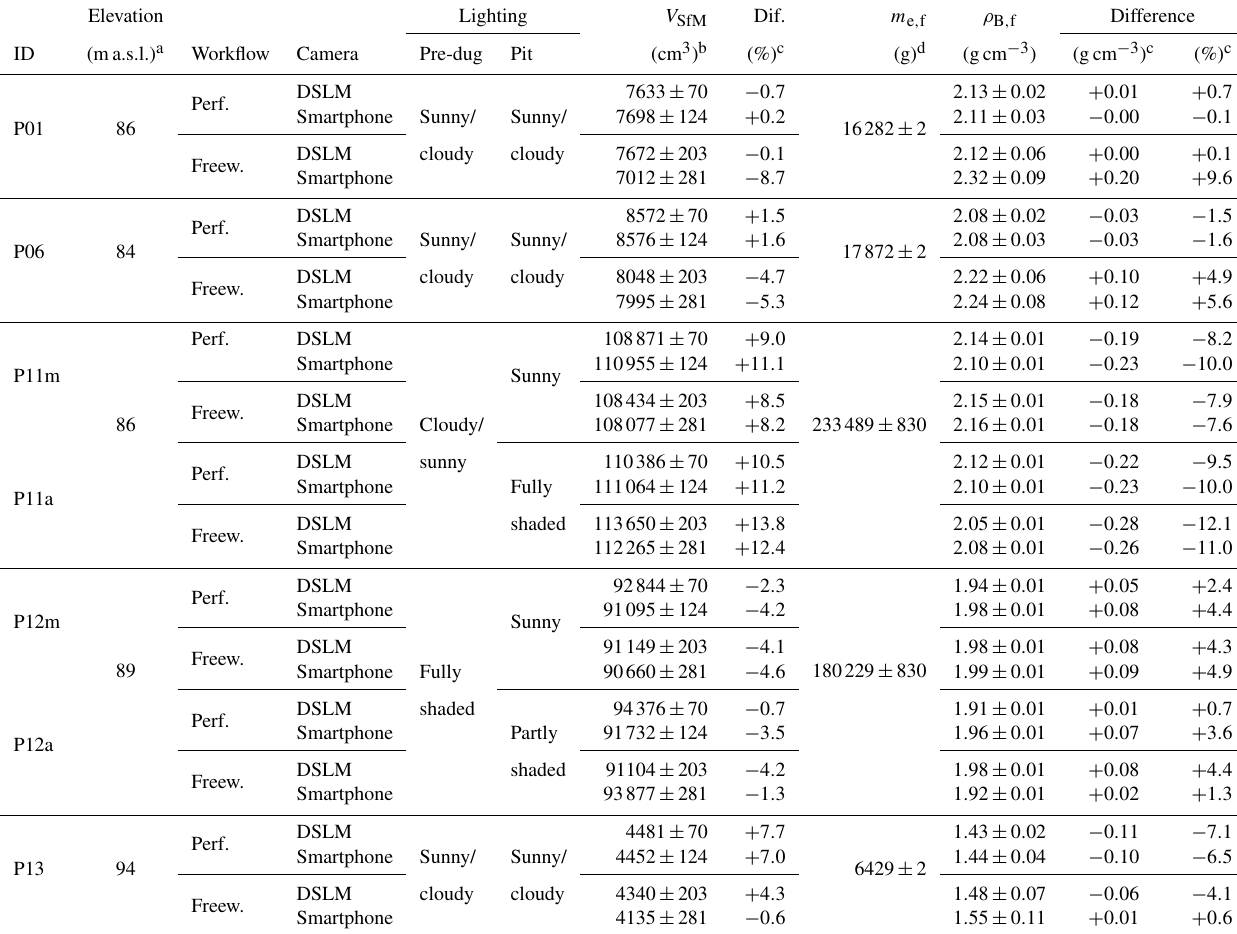
Table 4. Imaging scenarios, photogrammetry-derived volumes ( V SfM ), excavation weights (field state; m e , f ) and field bulk densities ( ρ B , f ) of the standard pits BD17-P01, BD17-P06, BD17-P11, BD17-P12 and BD17-P13. Elevation Lighting V SfM Dif. m e , f ρ B , f Difference ID (ma.s.l.) a Workflow Camera Pre-dug Perf. Smartphone P01 86 cloudy Freew.